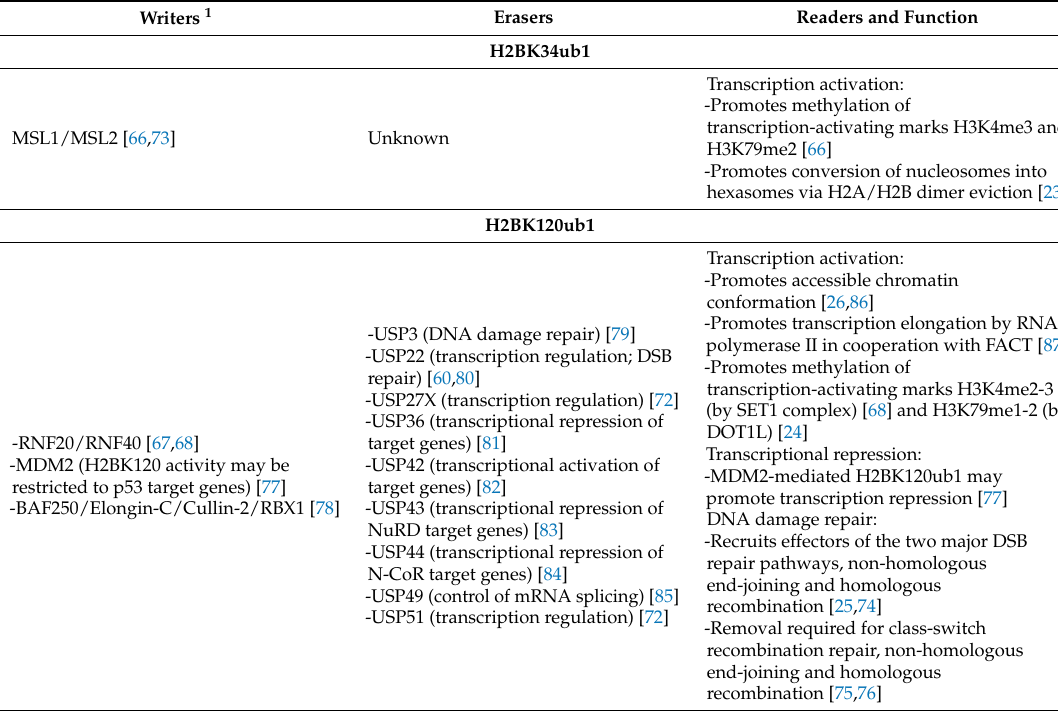
Table 2. Functions and regulation of histone H2B ubiquitination